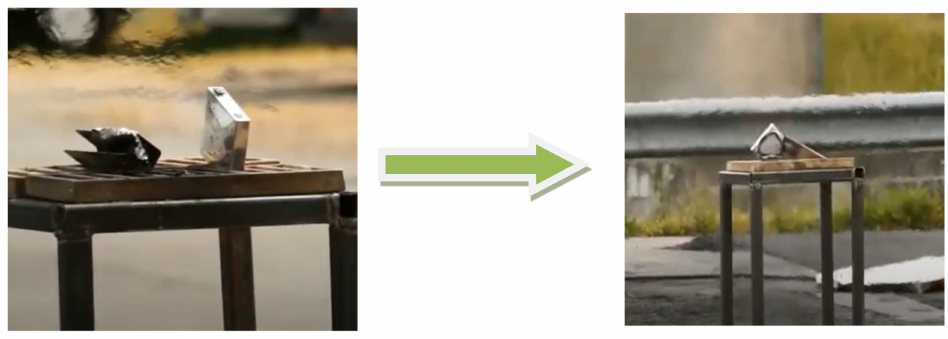
Figure 17. Exp. A.3 experiment.